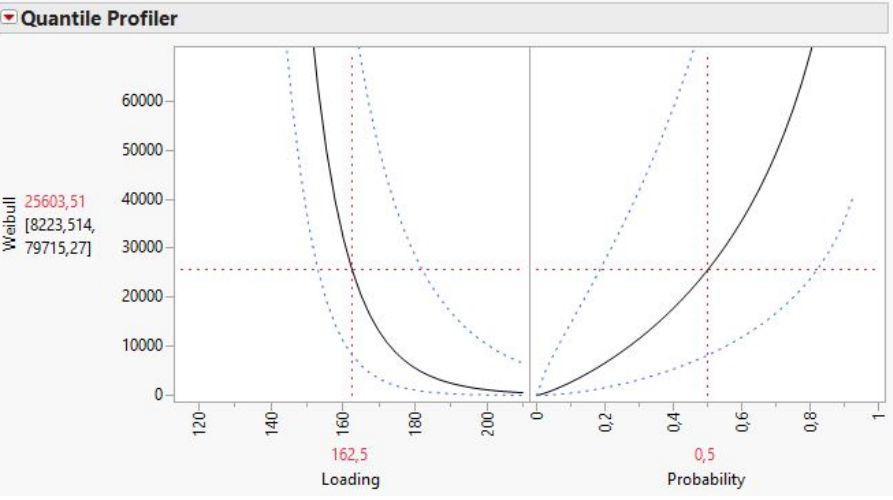
Figure 9. Quantile analysis for